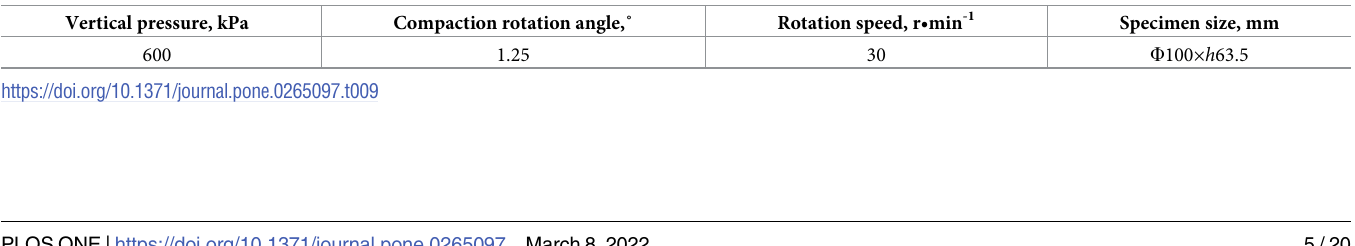
Table 9. Working parameters of the gyratory